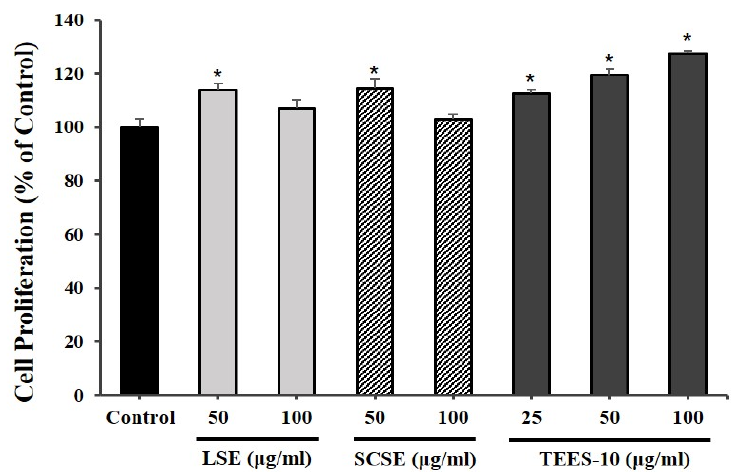
Figure 3. Effects of LSE, SCSE and TEES-10 ® on periodontal ligament (PDL) cell viability. PDL cells treated with TEES-10 ® exhibited increased viability in a concentration-dependent manner. Each bar indicates the mean ± SEM. ( n = 5). * p < 0.05 compared with the sham control group. LSE: L.stenocephala extract, SCSE: S. cereale sprout extract, TEES-10 ® : combination of LSE and SCSE.